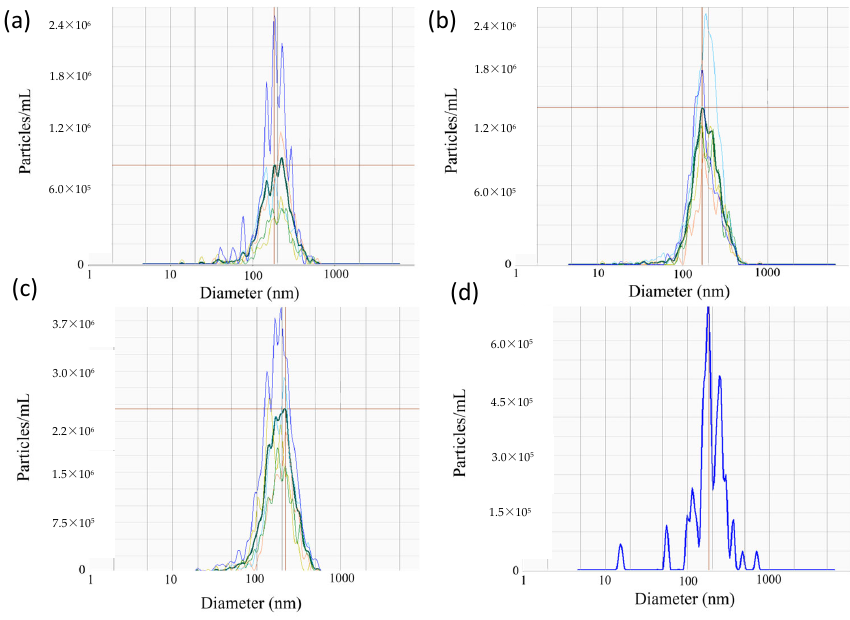
Figure 2. Representative spectra of EVs isolated from the ( a ) caput, ( b ) corpus, and ( c ) cauda of the epididymis (n = 5 males), as well as ( d ) whole epididymides (n = 1 pool of 5 males). Dark lines correspond to the segment average, whereas faint lines represent individual samples from which the average was derived. Red horizontal lines mark peak value of segment average.